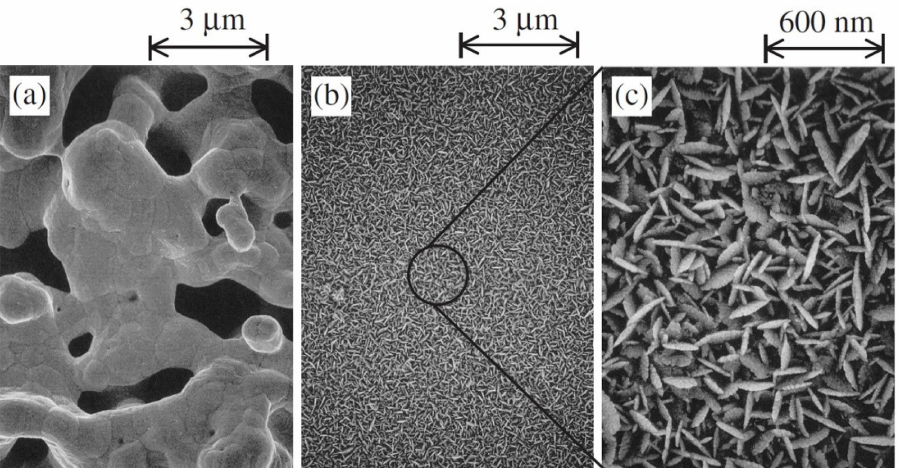
Figure 7. SEM of electrode surface; ( a ) pasted electrode (a magnification of × 10,000), ( b ) plated electrode (a magnification of × 10,000) and ( c ) plated electrode (a magnification of × 50,000). Reprinted with permission from Ref. [81]. Copyright 2004 Taylor &